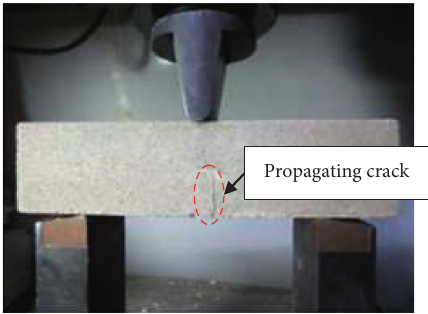
Figure 21: Destroyed flexural test specimen.